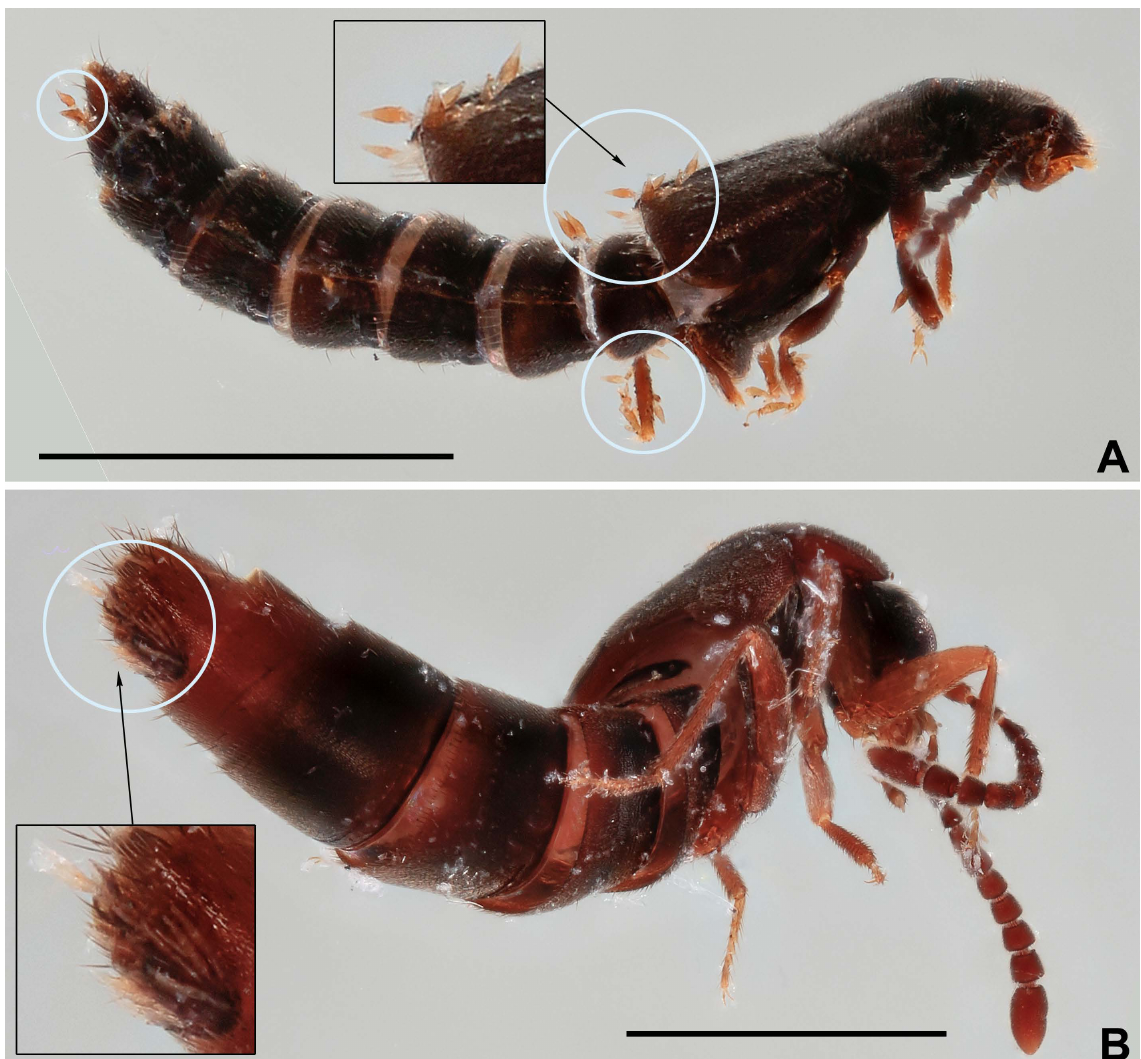
Fig. 107. Habitus of hosts with fungi. Some thalli are zoomed in, and others are encircled. A . Carpelimus corticinus with thalli of Cantharomyces orientalis on various parts of the body. B . Oxypoda elongatula with thalli of Monoicomyces crassicaulis on the ventral side of the last abdominal segment. Scale bars: 1 mm. (Photos: Aslak Kappel